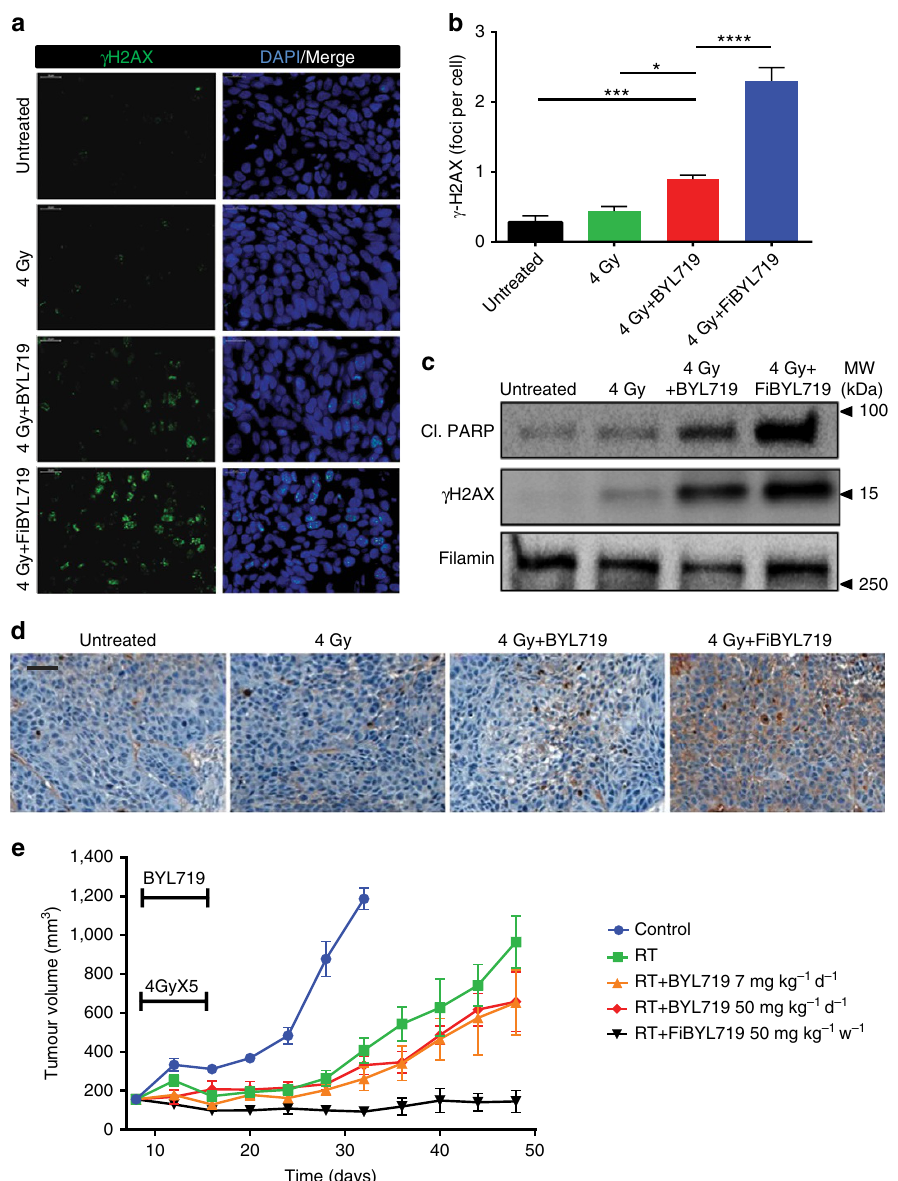
Figure 3 | Radiosensitization effects of pre-clinical HNSCC models by free and nanoparticle-encapsulated BYL719. ( a ) Representative images of immunofluorescence staining for nuclear g H2AX foci (green) and DAPI (blue) in H22 patient-derived xenografts 24h post treatment with RT (4Gy) or RT followed by 50mgkg (cid:2) 1 BYL719 or 25 mgkg (cid:2) 1 FiBYL719. Scale bar, 20 m m. ( b ) Quantification of g H2AX staining (foci per cell) presented in a ( n ¼ 3). ( c ) Western blot of g H2AX and cleaved PARP in H22 patient-derived xenografts 24h post treatment with RT (4Gy), RTand 50mgkg (cid:2) 1 BYL719, or 25mgkg (cid:2) 1 FiBYL719 ( n ¼ 3). ( d ) Representative images of immunohistochemical staining for TUNEL in H22 patient-derived xenografts 24h post treatment with 4Gy RT, 4Gy RT plus 50mgkg (cid:2) 1 BYL719, or 4Gy RT plus 25mgkg (cid:2) 1 FiBYL719. Scale bar, 50 m m. ( e ) Tumour growth curves of H22 patient-derived xenografts treated for 5 days with daily oral administration of either 50 or 7mgkg (cid:2) 1 BYL719 daily, or with i.v. injections of 25mgkg (cid:2) 1 FiBYL719 administered bi-weekly, combined with fractionated RT of 4Gy (cid:3) 5 doses on days 1–5 ( n ¼ 10). In b , e , error bars indicate mean ±